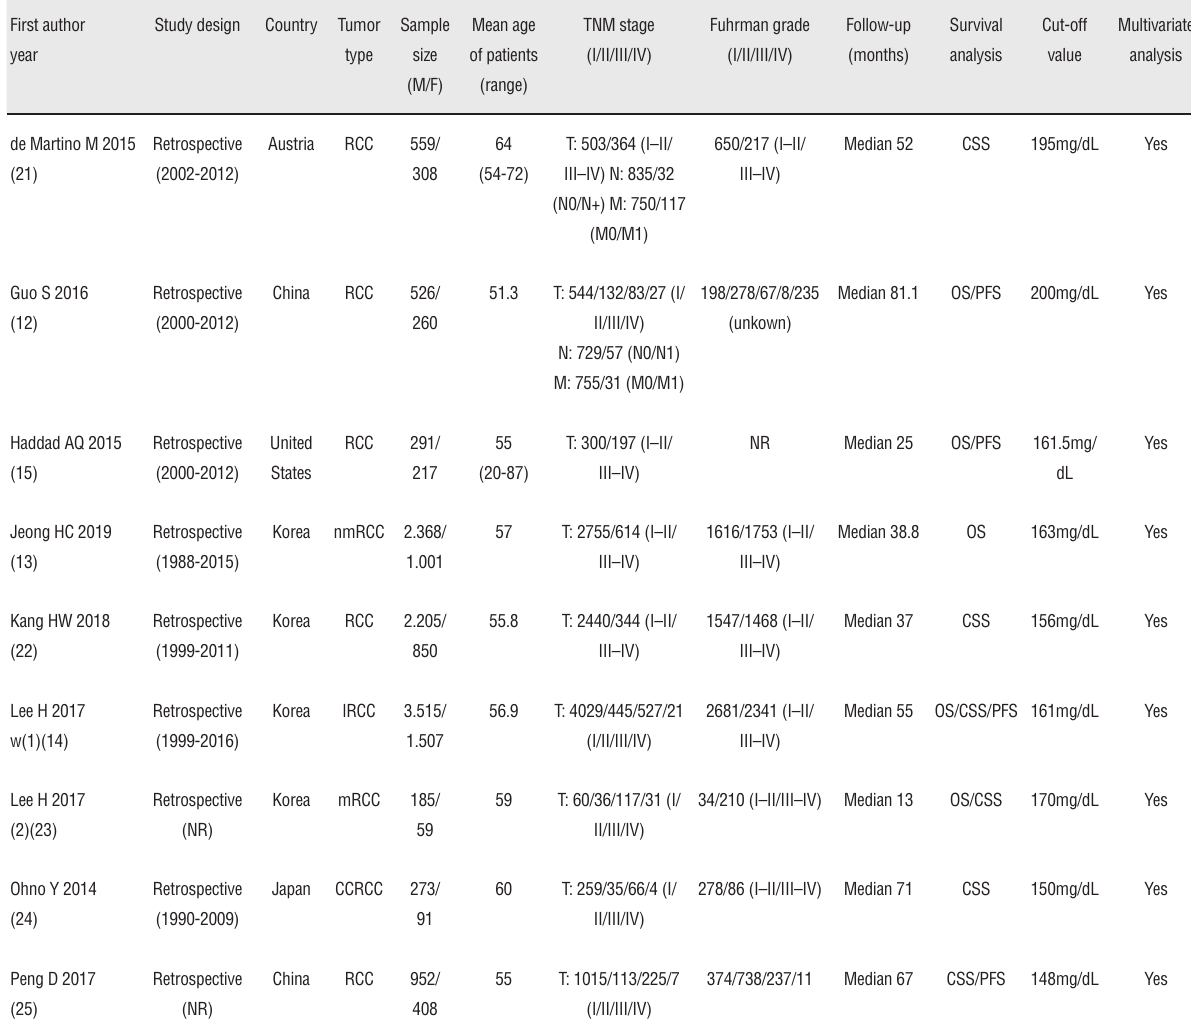
Table 1 - Characteristics of the included